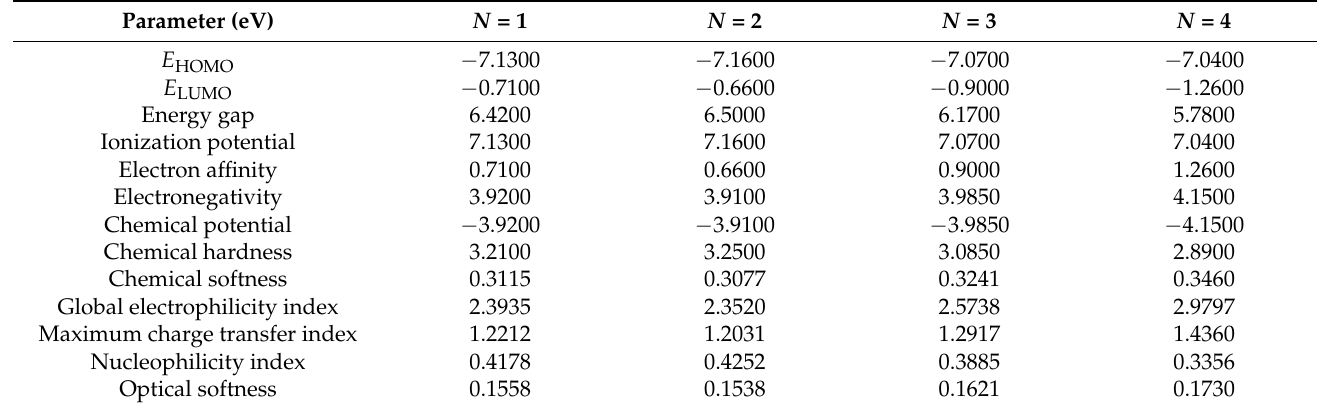
Table 6. Physiochemical descriptors calculated using the FMO energies.